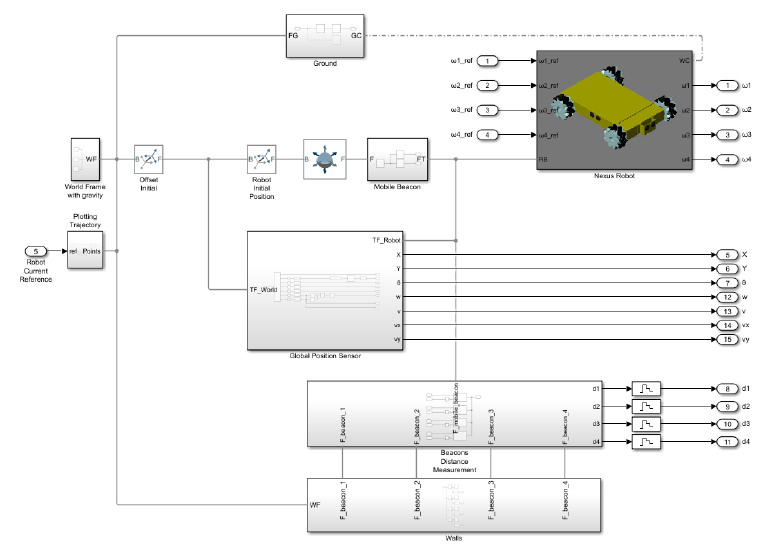
Figure 9. Simscape simulation model and